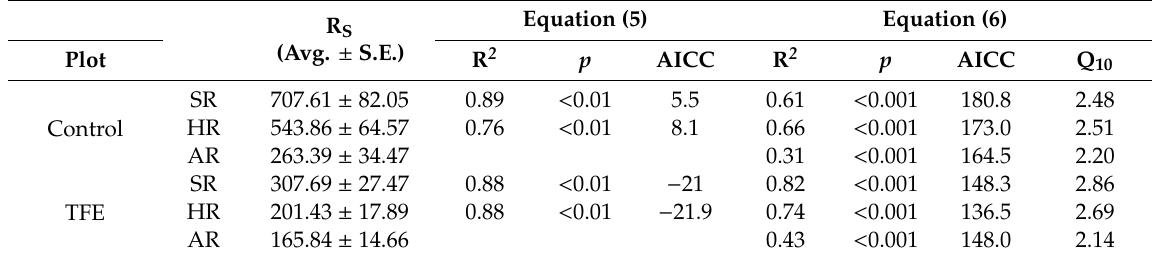
Table 4. Probabilities of the nonlinear relationships between measured soil respiration ( R S ) and soil temperature (Equation (6)) or combined e ff ect of soil temperature and water content (Equation